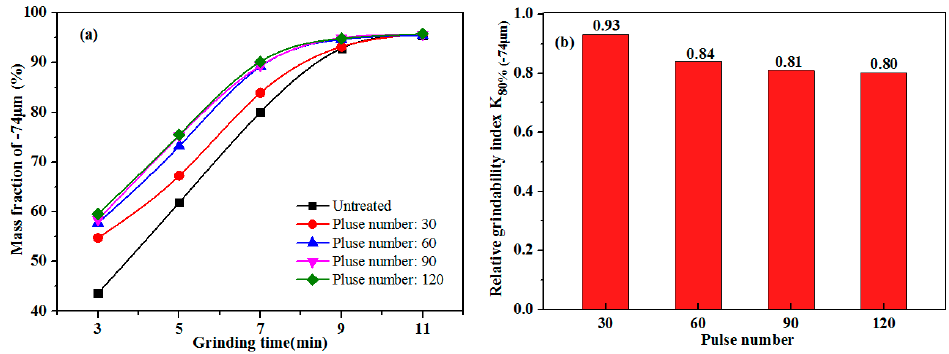
Figure 5. The effect of the pulse numbers on ( a ) mass fraction and ( b ) grindability index.